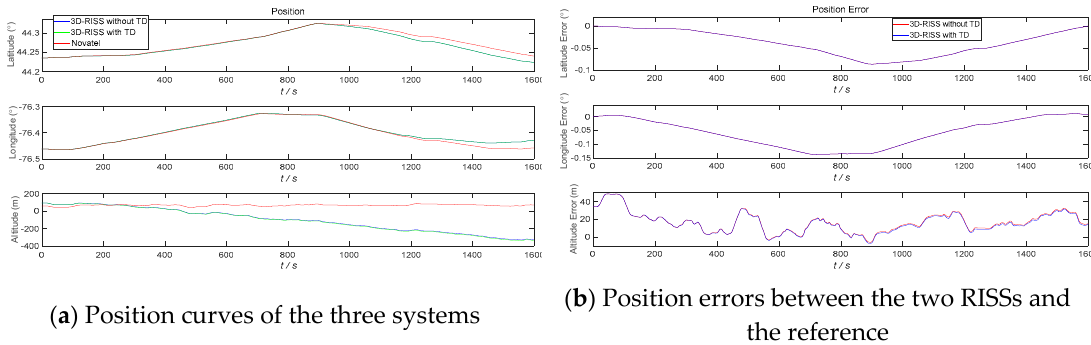
Figure 7. RISS position and position errors with the original odometer velocity filtered by TD.